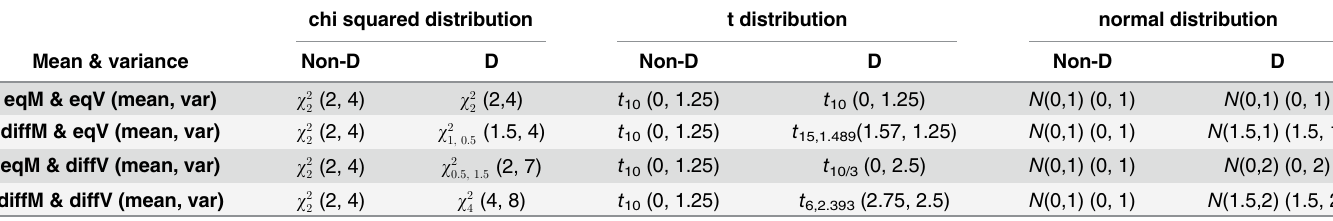
Table 1. The distribution settings for the scenarios in Simulation Study